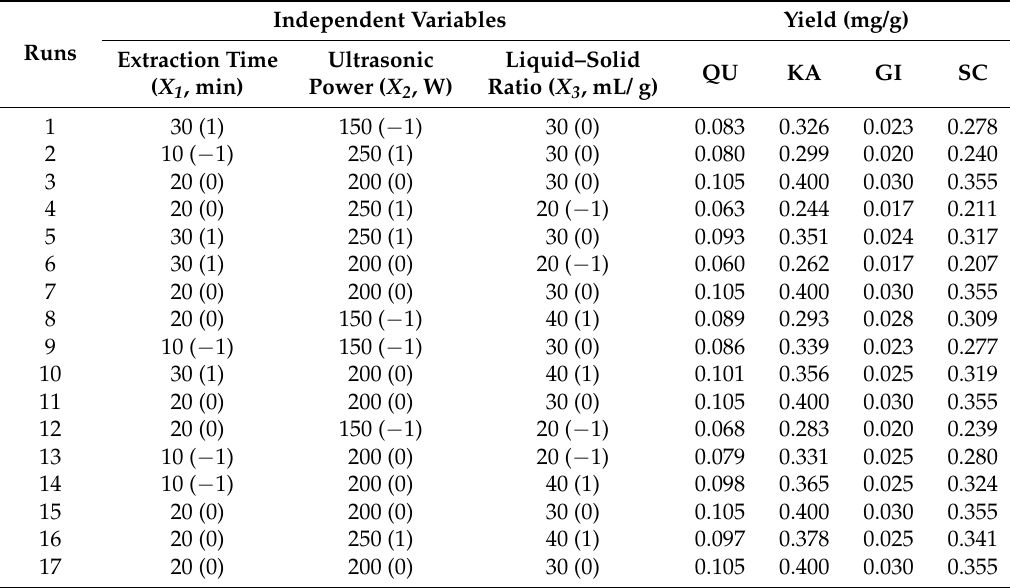
Table 2. The Box–Behnken design of independent variables for process